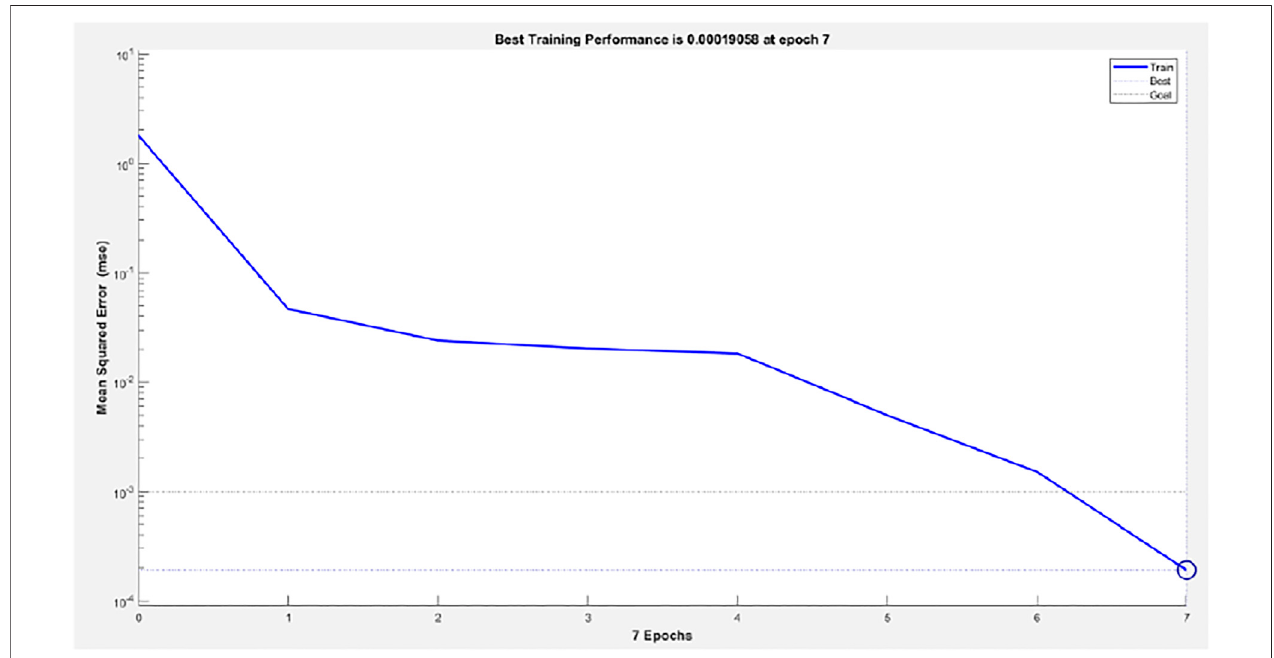
FIGURE 11 | Comparison diagram of the CSO BP neural network